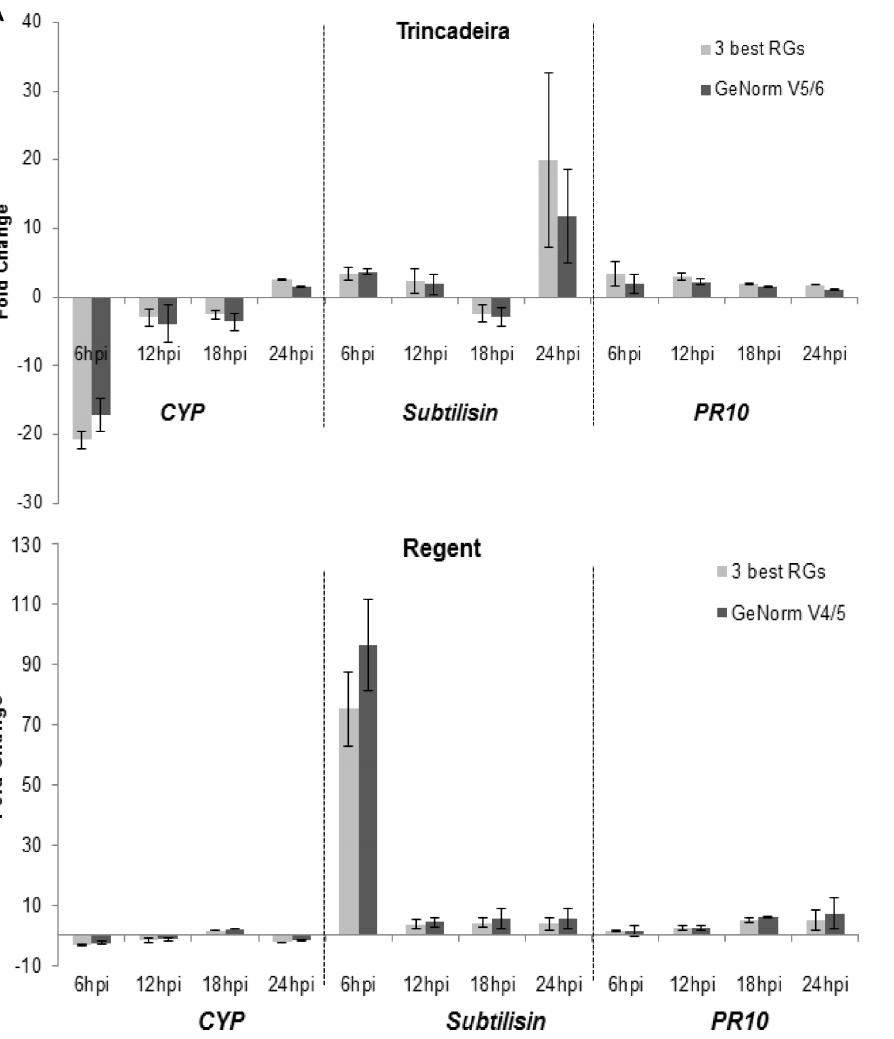
Figure 3. CYP , subtilisin , PR10 expression in Biotic Stress effect when comparing independently Trincadeira (a) and Regent (b). Two normalization strategies are presented. Fold Change: expression of inoculated leaves (6, 12, 18 and 24 hpi) divided by mock inoculated samples. Asterisks indicate significant differences between each normalization strategy. RG, reference gene. Median and MAD (mean absolute deviation) values of three biological replicates are